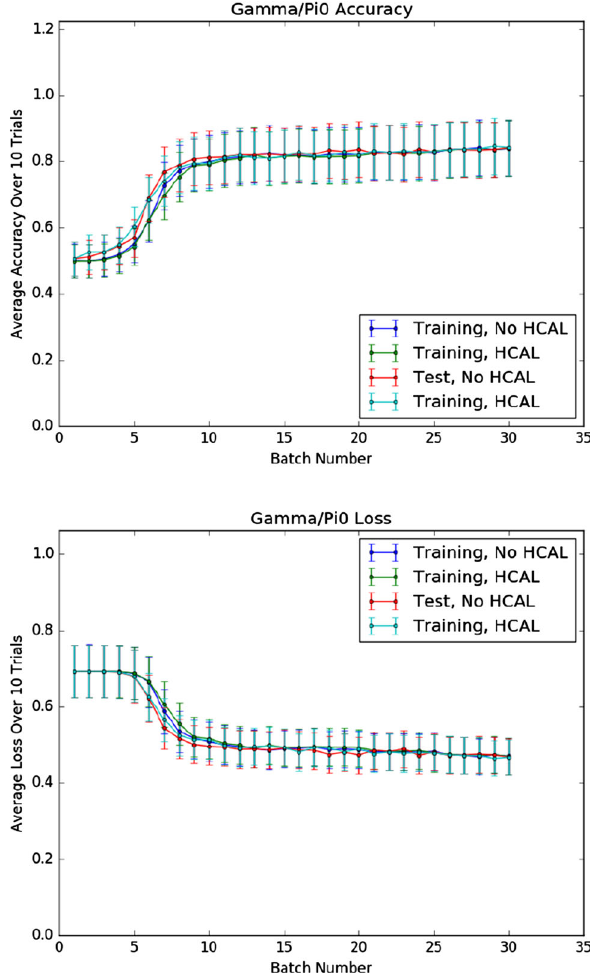
Fig. 31 Accuracy and loss curves for photon/neutral pion classifica- tion, with and without HCAL cells, using best DNN architecture